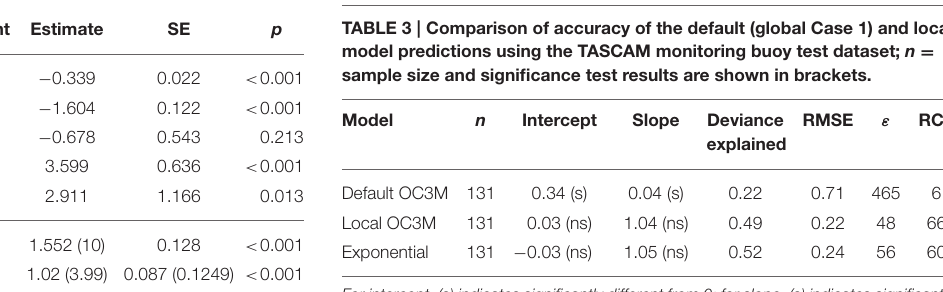
TABLE 2 | Summary of results of the two locally-tuned models for Tasman Bay trained on 6 h averaged data. Deviance explained